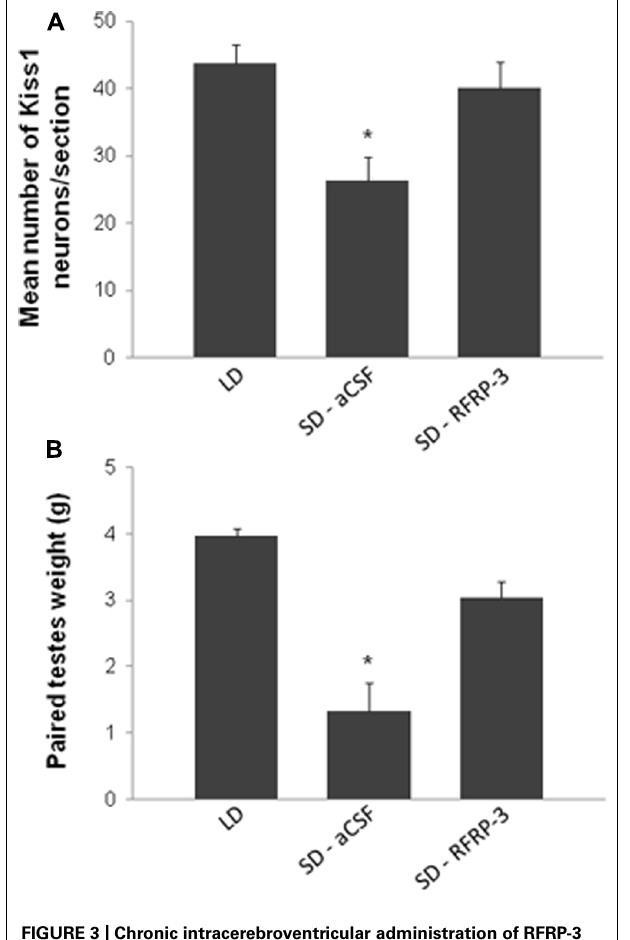
FIGURE 3 | Chronic intracerebroventricular administration of RFRP-3 [12 μ g/day for 5 weeks in artificial cerebrospinal fluid (aCSF)] in sexually inactive short day (SD)-adapted male Syrian hamsters increases kisspeptin expression in the arcuate nucleus (A) and testicular weight (B) up to values comparable to animals kept in long day (LD) conditions. * p < 0.05 when compared to LD or RFRP-3 treated SD animals. Adapted from Ancel etal.